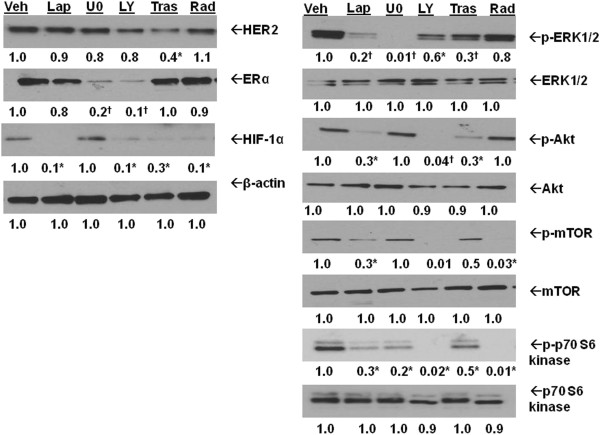
Regulation of HIF-1α protein in LTLTCa cells. A) LTLTCa cells were treated with either vehicle, 1 μM lapatinib, 20 μM MAPK pathway inhibitor U0126, 20 μM LY294002 PI3K pathway inhibitor, 500 μg/ml trastuzumab or 100 nM RAD001 for 24 hours. Total protein was extracted and HER2 (P = 0.128), phospho- and total-ERK1/2 (P <0.0001 for p-ERK), phospho- and total-Akt (P <0.0001 for p-Akt), phospho- and total mTOR (P = 0.0071), phospho- and total p70 S6 kinase (P <0.0001), ERα (P <0.0001), HIF-1α (P = 0.0003), and β-actin were analyzed by Western blot. Shown are representative blots and overall densitometry results of n = 6 independent cell samples/group. Densitometry results are expressed as mean fold-change in protein levels compared to vehicle-treated cells after normalization to β-actin (mean ± SD, n = 6 independent cell samples/group; *versus vehicle, P <0.05; † versus vehicle, P <0.001, one-way ANOVA). ANOVA, analysis of variance; ERα, estrogen receptor alpha; HER2, human epidermal growth factor receptor 2; HIF-1α, hypoxia inducible factor 1 α subunit; n, number; SD, standard deviation; mTOR, mammalian target of rapamycin.